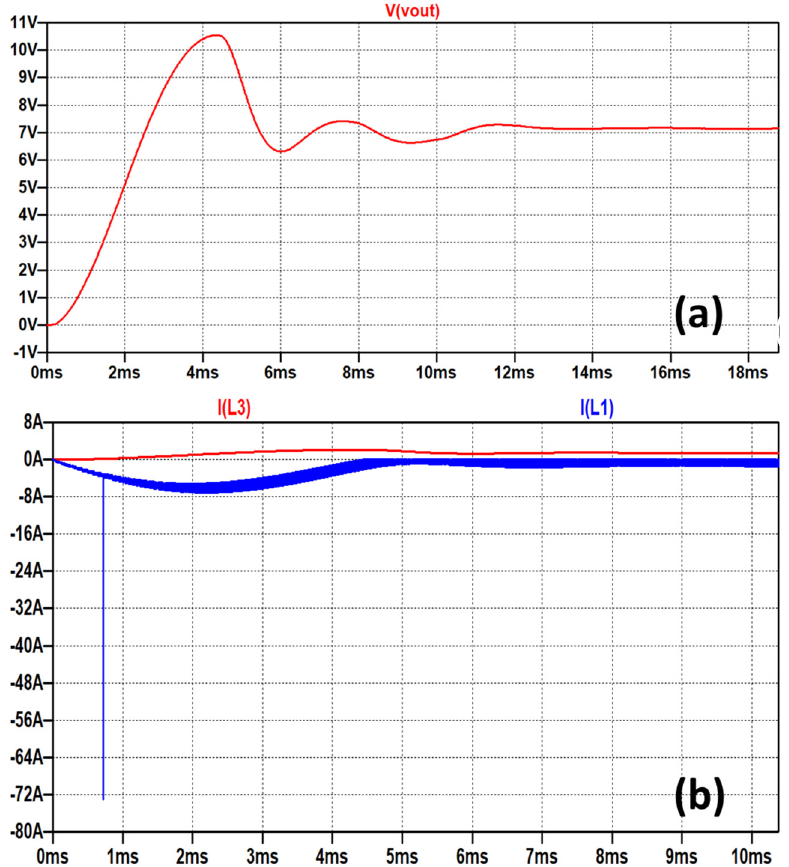
Figure 17. ( a ) The output voltage response with GaN switch and RLC load; ( b ) the input and output current responses with GaN switch and RLC load.